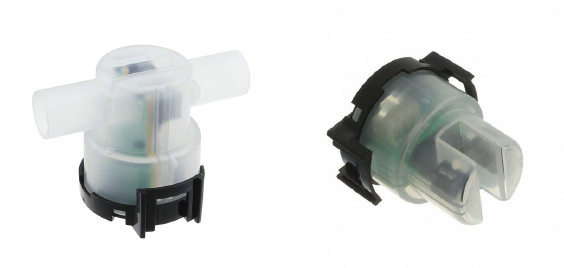
Figure 1. Amphenol TST-10 ( left ) and TSD-10 ( right ). TSW-10 is similar to the TSD-10 (not pictured) (images from Amphenol).